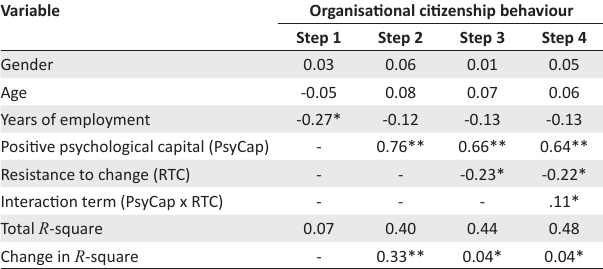
TABLE 3: Hierarchical regression of organisational citizenship behaviour regressed on positive psychological capital and resistance to change ( N =